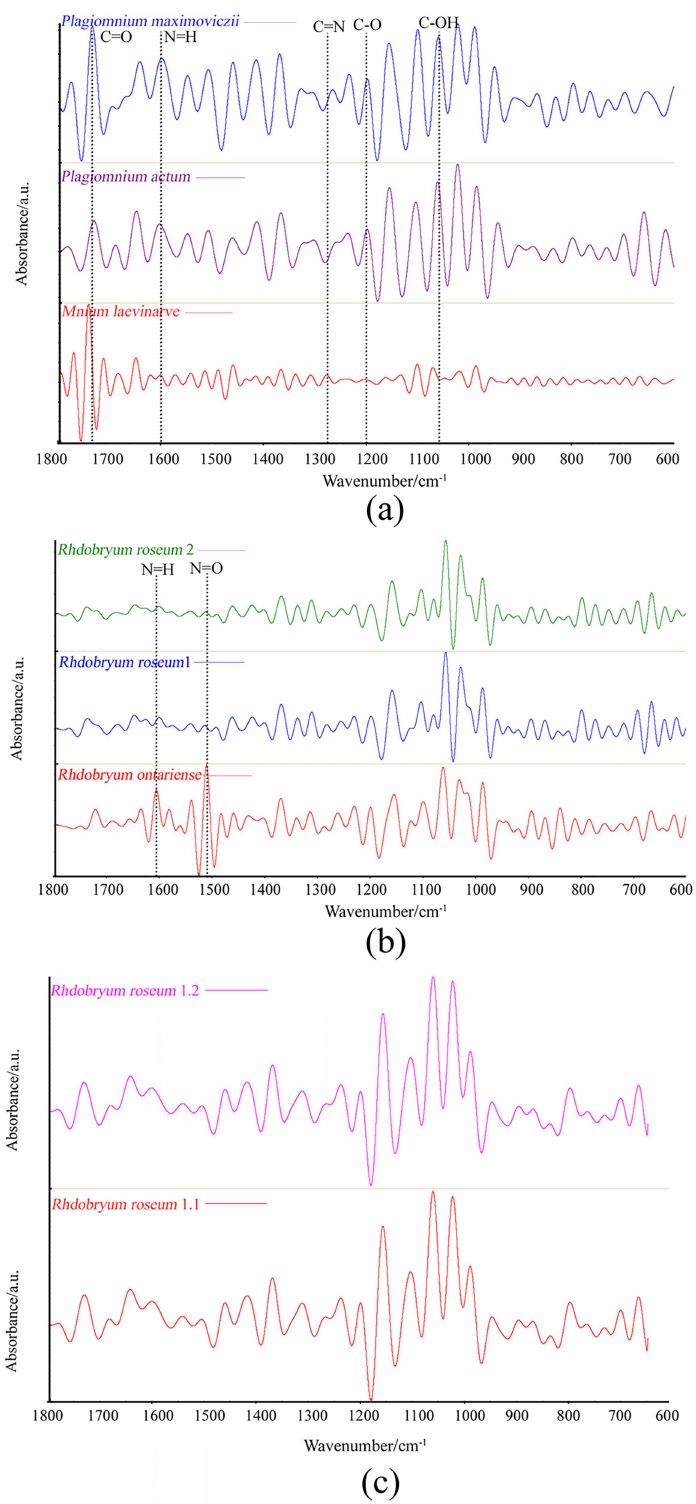
Fig 5. FSD FT-IR Spectra in the 1 800–600cm − 1 Region in the Whole Plants of the 6 Samples. The characteristic absorptionbandsare indicatedat the